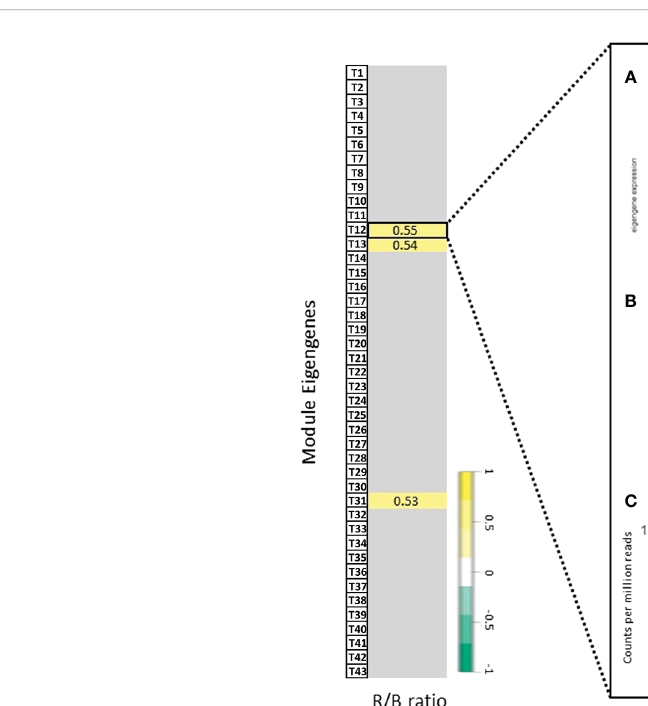
FIGURE 7 Gene expression in tomato correlated with R/B ratio. Module-trait relationships and differential gene expression between tomato fi lter treatments and control. (A) Normalized expression of the Tomato Module 12 eigengene expression for each treatment by sample. The correlation coef fi cient ( r ) is given for each relationship. Insigni fi cant correlations were removed (p<0.05). See Figures S14, S15 for full module-trait relationships tables. (B) Heatmap of gene expression for all genes in Tomato Module 12, where dark green indicates a strong increase in expression and dark yellow indicates a strong decrease in expression. (C) Normalized gene expression of a Tomato Module 12 hub gene, self pruning 5G ( SP5G ). The treatment with the highest R/B ratio, FP (FTAZ : PCBM fi lter), had higher gene expression in Tomato Module 12, resulting in a positive correlation with the R/B ratio. This correlation is exempli fi ed in a hub gene of Tomato Module 12: SPG5 . Error bars indicate the standard deviation. Letters indicate signi fi cance from ANOVA and Tukey test